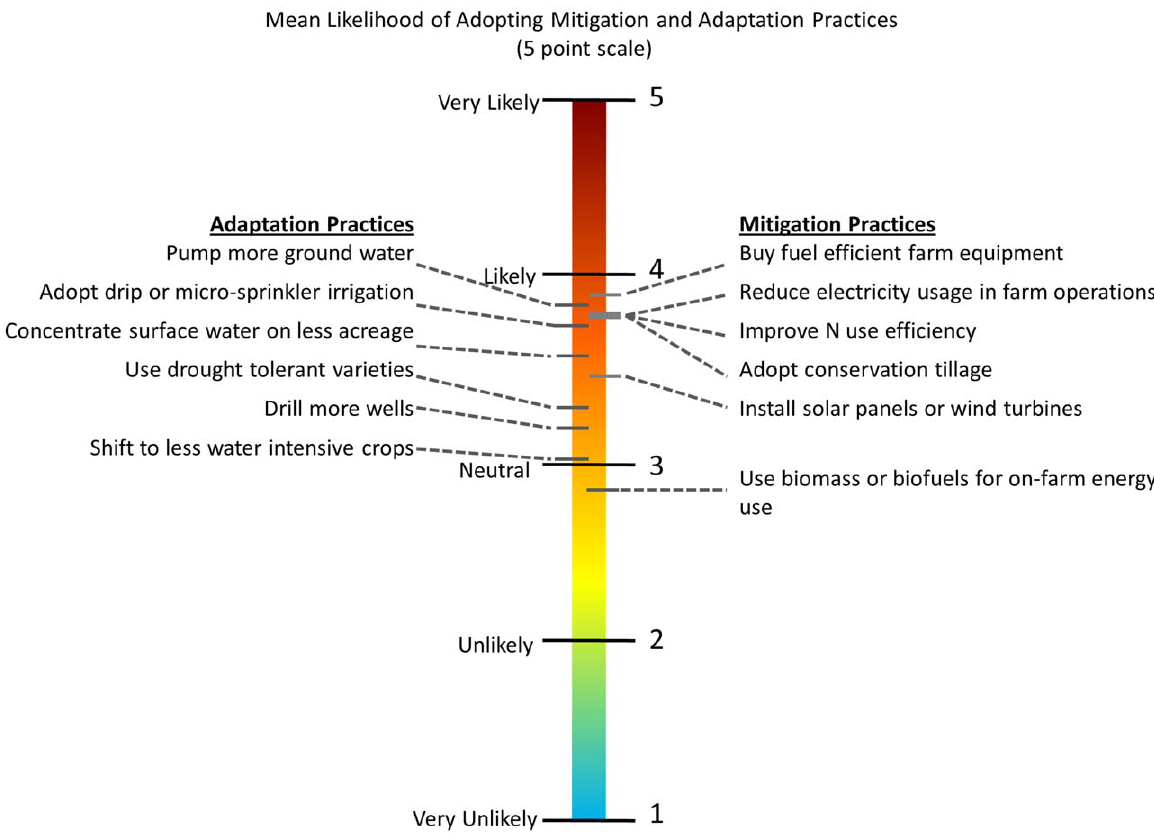
Figure 1. Mean likelihood of farmers adopting various mitigation and adaptation practices as measured on a 5 point scale.